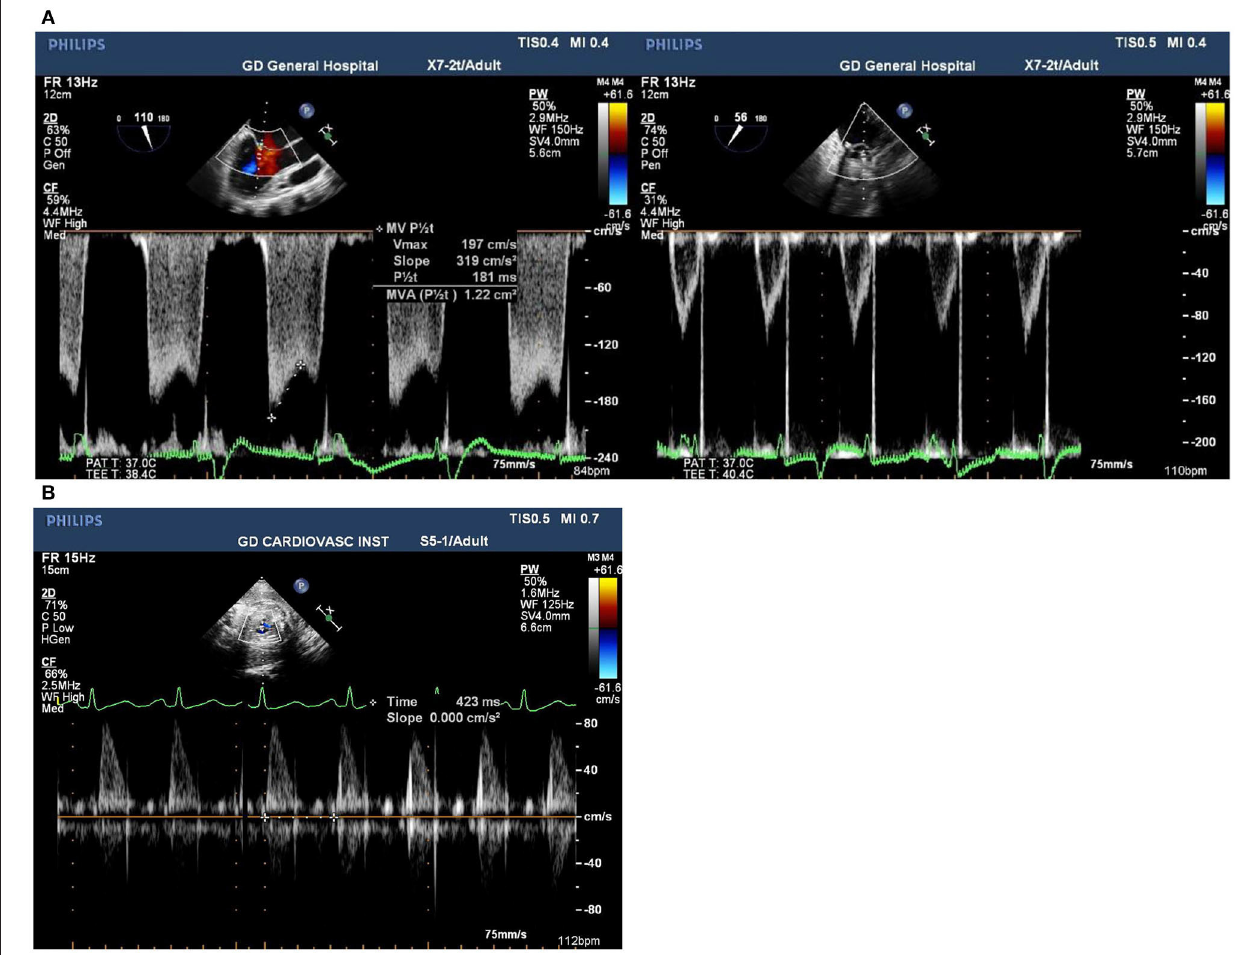
FIGURE 1 | (A) Pre and post-surgical mitral valve view of transesophageal echocardiogram images of mitral valve stenosis in Case 1. (B) Postoperative transesophageal echocardiogram images of Doppler of fetal blood flow in Case 3 presenting the fetal heart rate at 141 bpm.